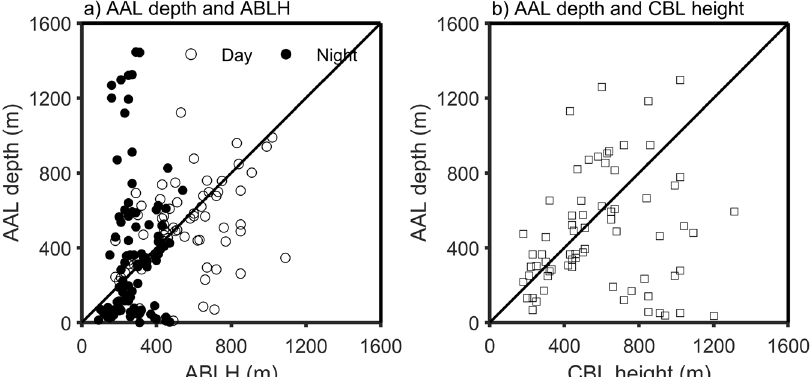
Fig. 8 Comparisons between the AAL depth and the ABLH. a the AAL depth and ABLH, b the nighttime AAL depth and the CBL height on the same day of six observation stations.